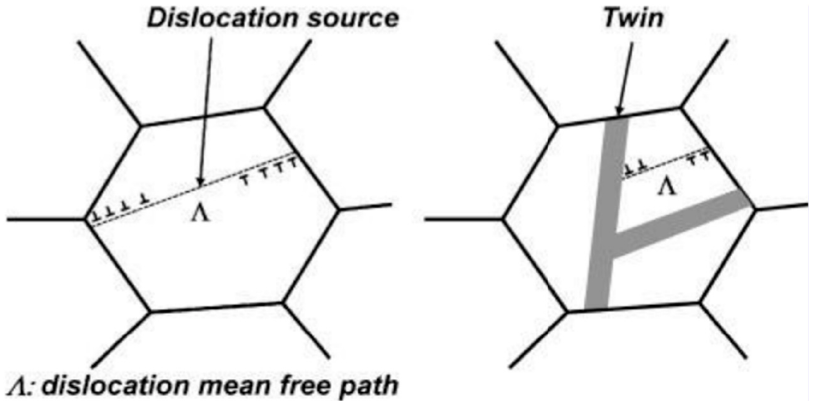
Figure 3. Schematic of strain hardening mechanism in TWIP steels [14]. (Reproduced with permission from refs. [14]. Copyright (2012), Taylor & Francis).